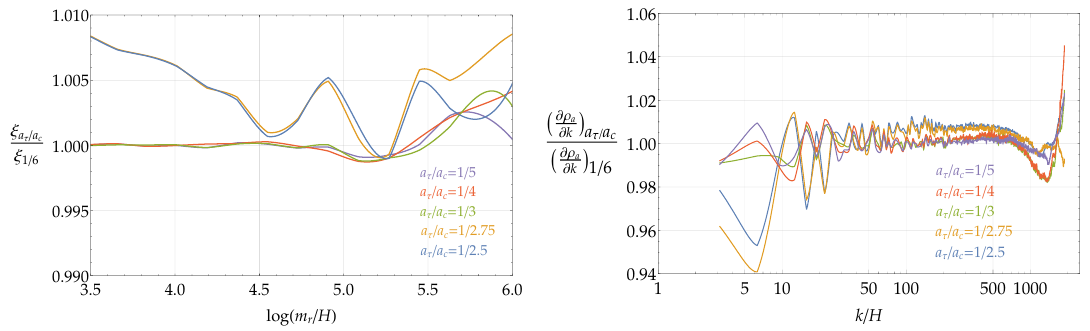
Figure 16 . Results for (cid:24) ( t ) (left) and the axion spectrum at log( m r =H f ) = 6 (right), for di(cid:11)erent choices of the time-step a (cid:28) . This is measured relative to the comoving space-step a c , which is (cid:12)xed to m i a c = m r a = 0 : 67, and the (cid:12)nal box size is (cid:12)xed to H f L f = 2. The results are normalized to the shortest time step tested: a (cid:28) =a c = 1 = 6.